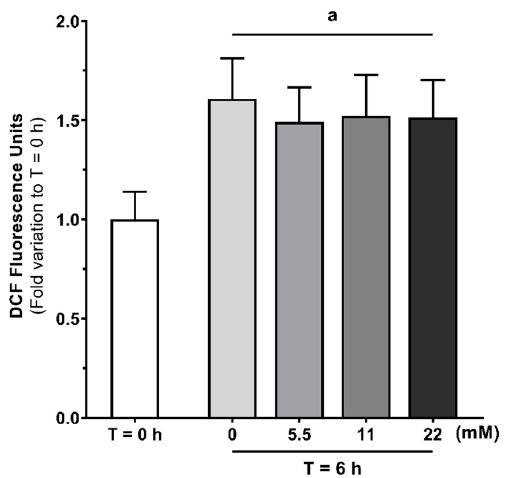
Figure 6. Evaluation of endogenous ROS production in human spermatozoa at baseline (T = 0 h) and without or with glucose (0, 5.5, 11 and 22 mM) stimuli following 6 h in capacitation conditions, using the fluorogenic dye CM-H2DCFDA. Results are expressed as mean ± SEM ( n = 15 for each condition). Significantly different results are expressed as: ( a ) Relative to T = 0 h group.